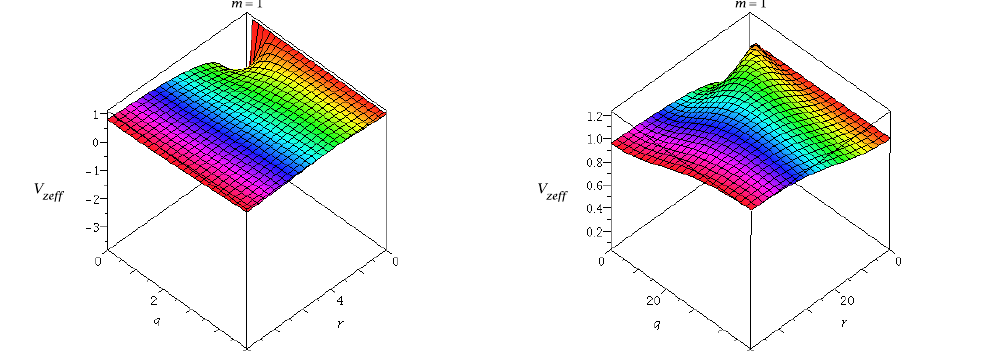
Figure 3. The figure depicts the variation of V zef f with r for various values of q . Here m = 1.